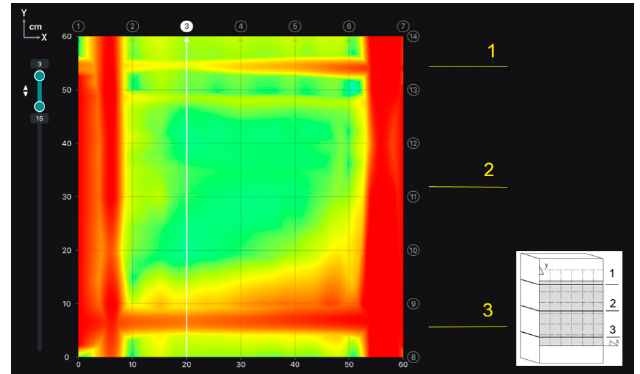
Figure 7. B-scans (sectional view of the element) of the masonry specimen No. 1 from tests performed with: ( a ) ultrasonic tomography, ( b ) GPR scanner, 1 —location of steel mesh with a diameter of 1.2 mm, 2 — location of fibreglass mesh (size 10 × 12 mm), 3 — location of basalt mesh (size 30 × 30 mm).